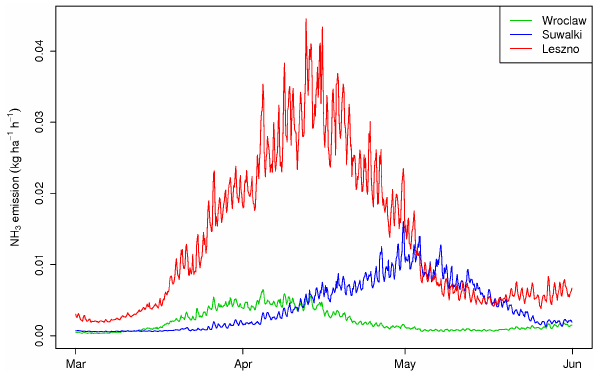
Figure 5. The hourly variation in simulated NH 3 emissions for POLREGUL scenario. Data from March to May for three locations in Poland (Wrocław, Suwałki and